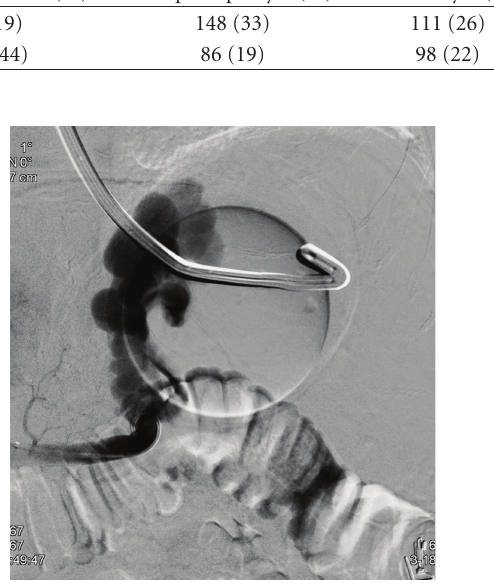
Figure 5: Transjugular portography in a patient bleeding from gastric varices. Note that balloon tamponade did not suppress fundal varices